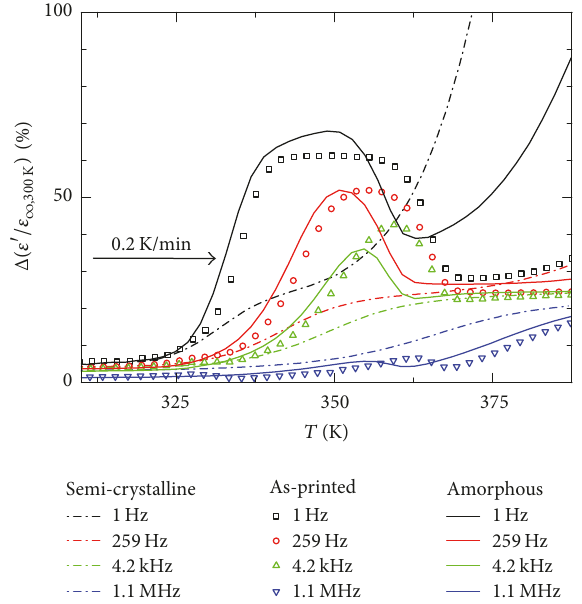
Figure 4: Comparison of the normalized (to 𝜀 󸀠 at 300 K) dielectric constant 𝜀 󸀠 for PLA in the amorphous (solid lines), as-printed (closed symbols), and semicrystalline (dashes-dotted lines) state. The displayed result of the relative change in 𝜀 󸀠 is shown for the heating curve at a rate of 0.2 K/min for various